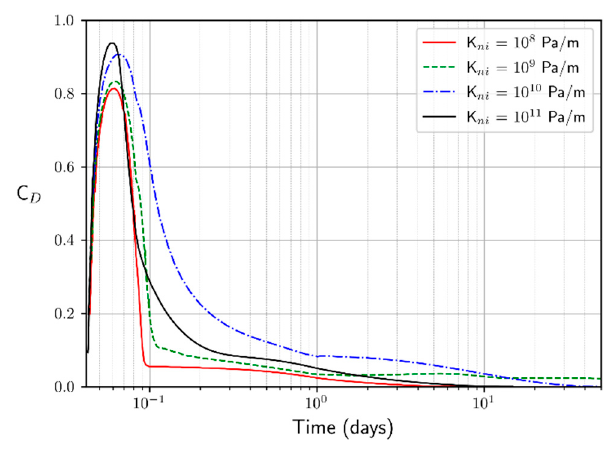
Figure 10. Fracture closure rate is controlled by stiffness (K ni ).